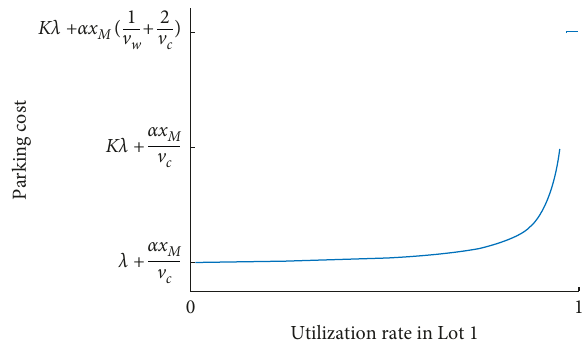
Figure 3: Parking cost of parking lot 1 in varying utilization